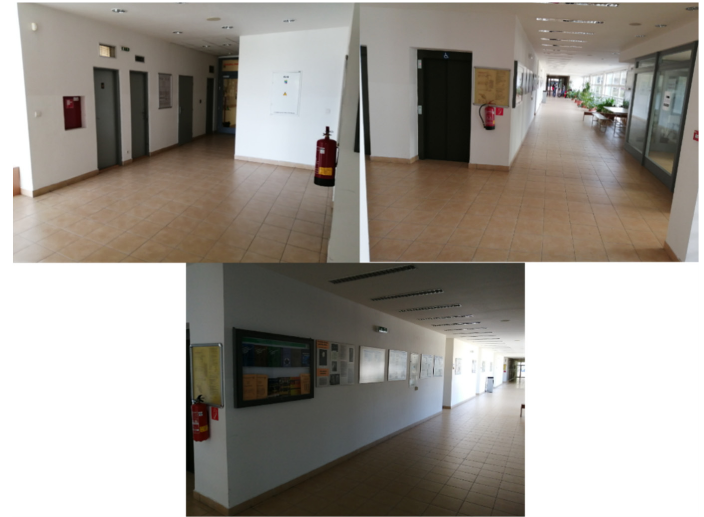
Figure 10. Mapped spaces on real photos.